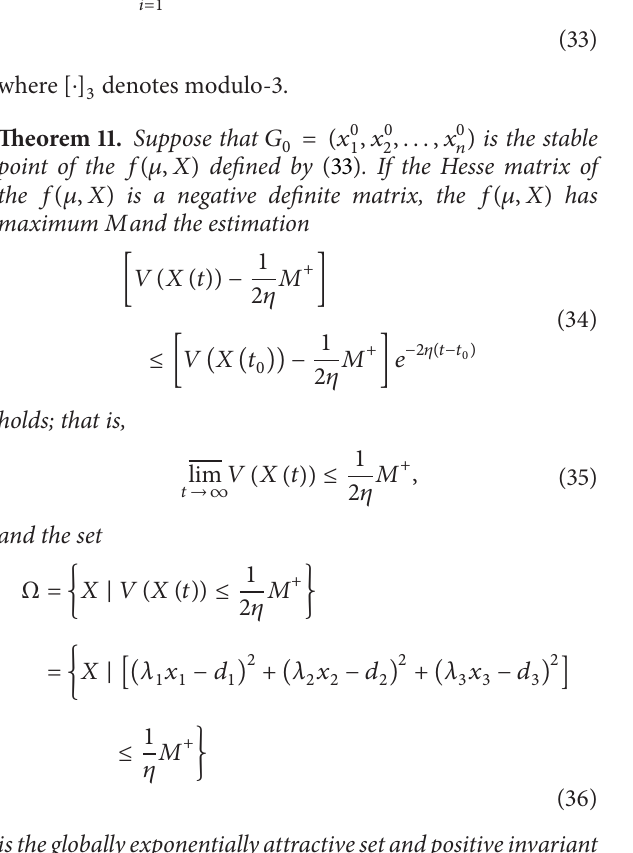
Figure 1: Simulation of system (40).